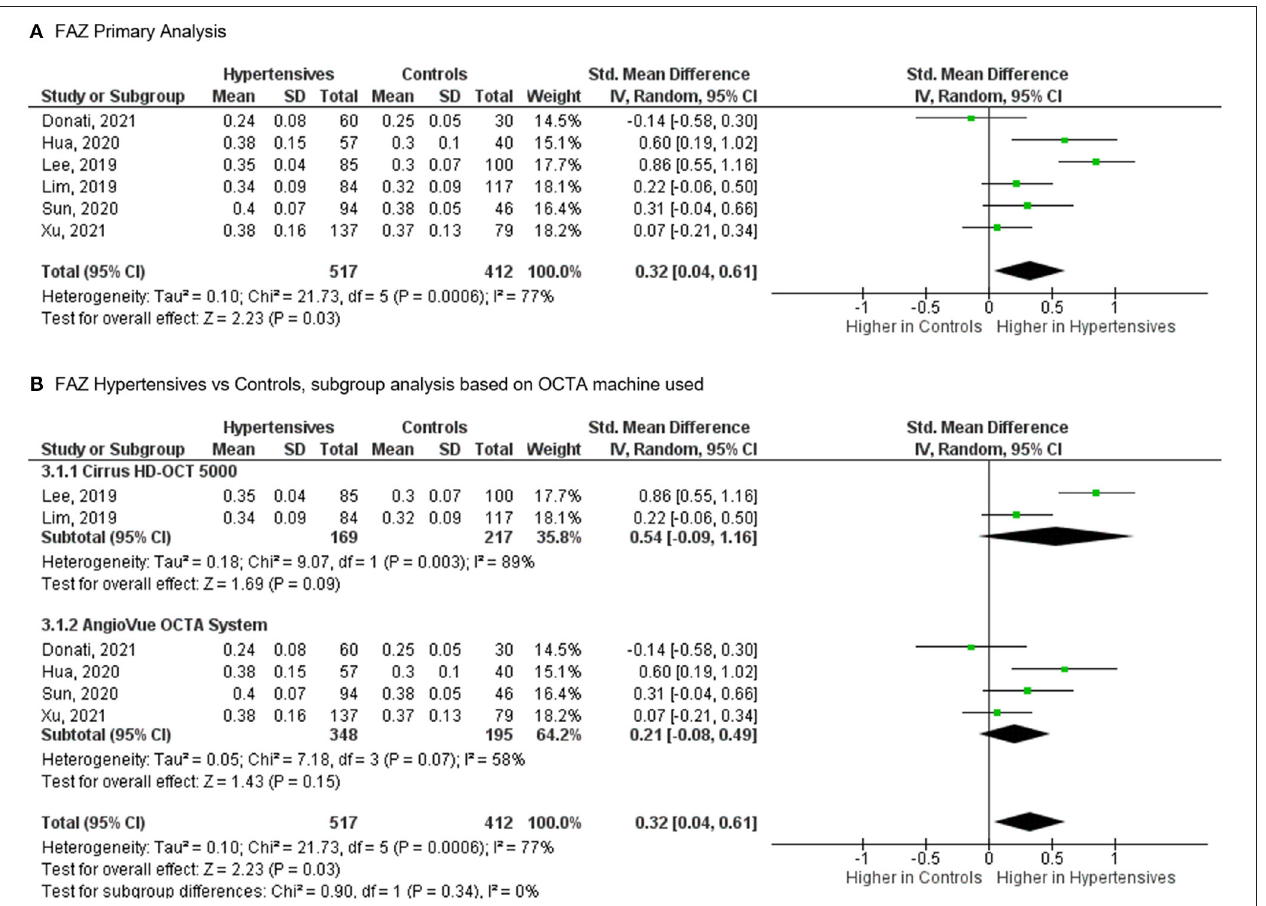
FIGURE 5 | (A) Meta-analysis of superficial foveal avascular zone (FAZ; SMD) and (B) FAZ subgroup analysis based on OCTA devices for patients with systemic hypertension vs. controls. Mean and standard deviation (SD) are included, with 95% confidence intervals (CIs), heterogeneity scores, and overall effect in an inverse variance (IV) random effects model. The green square size represents the weight attributed to each study based on relative sample